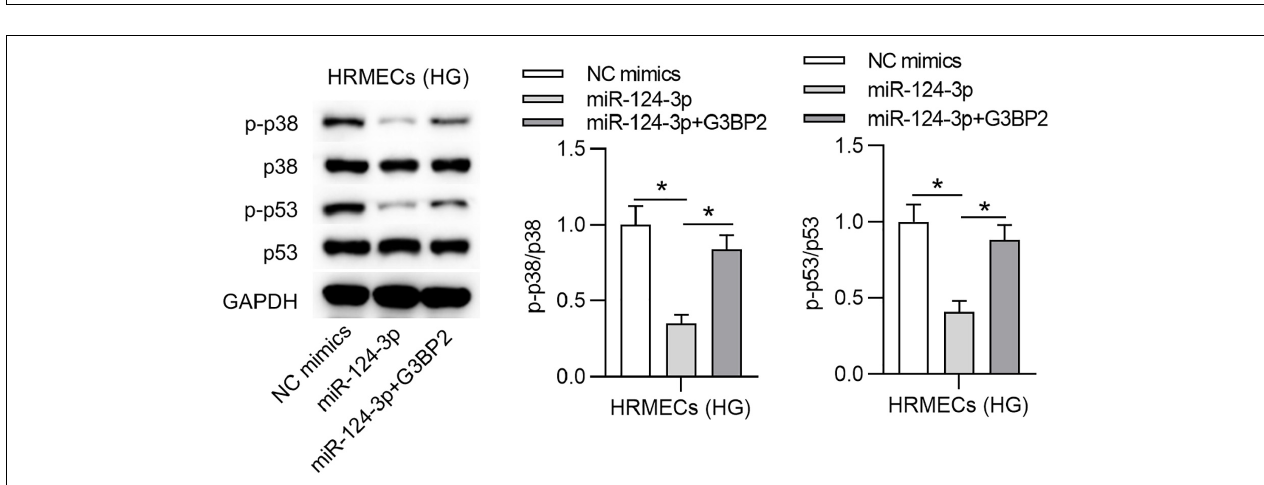
FIGURE 5 | MiR-124-3p inhibited the p38MAPK signaling pathway through G3BP2. The levels of proteins of p38, p53, phosphorylated p53 and p38 in HG (30 mM glucose)-stimulated HRMECs for 48 h followed by transfection of miR-124-3p mimics or co-transfection of miR-124-3p + G3BP2 for 24 h were analyzed by western blot analysis. * P <